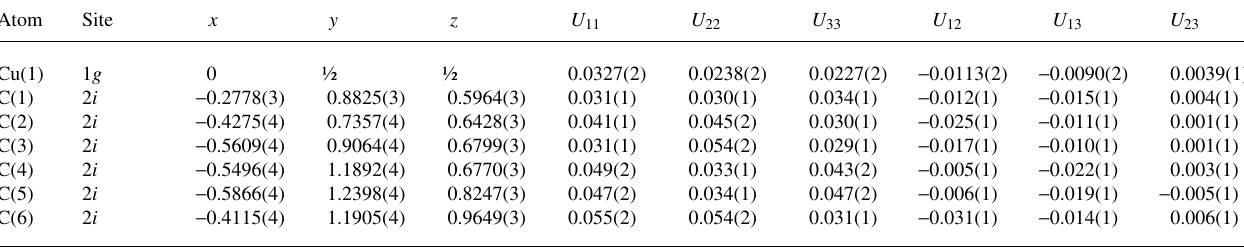
Table 3. Atomic coordinates and displacement parameters (in Å 2 )